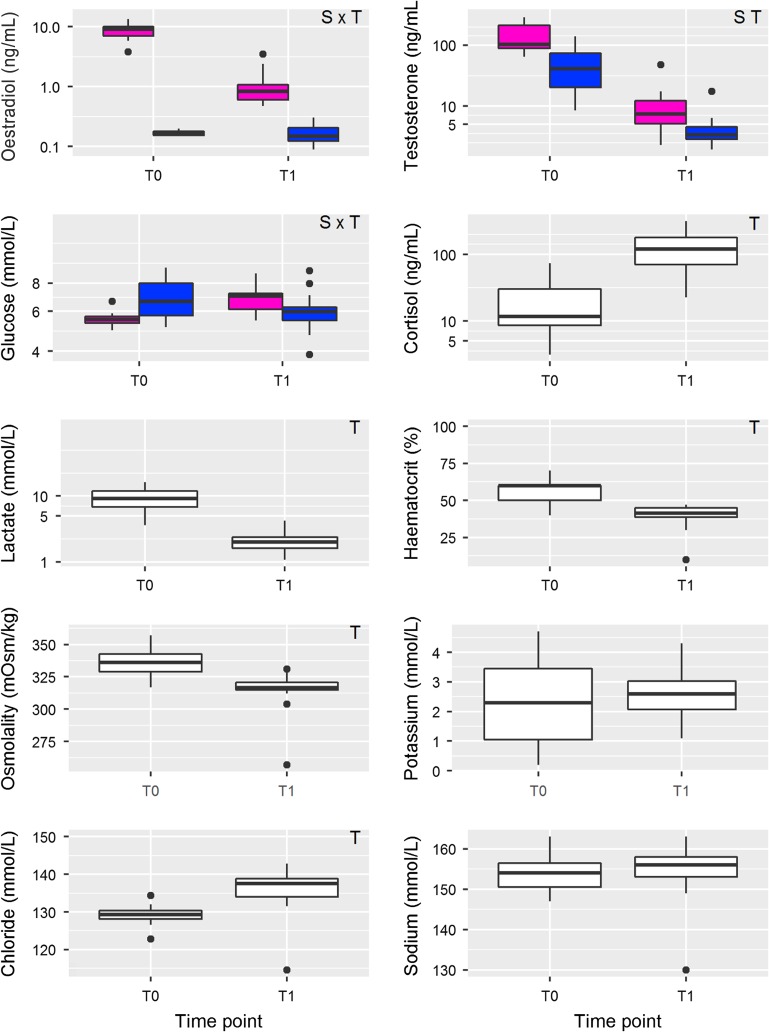
Box plots illustrating blood plasma indices of maturation (oestradiol and testosterone), metabolic stress (glucose, cortisol, lactate, haematocrit), and osmoregulatory and ionic imbalance (osmolality, potassium, chloride, sodium) measured in Early Stuart sockeye at the time of gillnet capture (T0; n = 19) and 2 days following gillnet capture (T1; n = 28). Oestradiol, testosterone, cortisol and glucose models included a significant sex factor showing differential changes for females (pink) and males (blue) at each time point. Letters at the top right of each plot denote significant differences (P < 0.05) between timepoints (T), sexes (S) or an interaction between the terms (S × T).